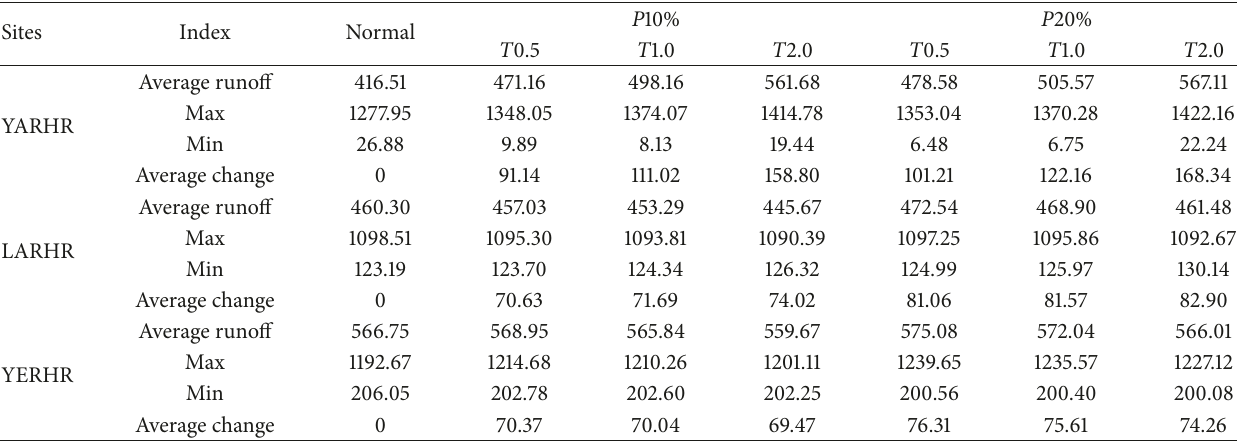
Table 10: The response of runoff to climate change at the Three-River Headwater Regions (m 3 /s).